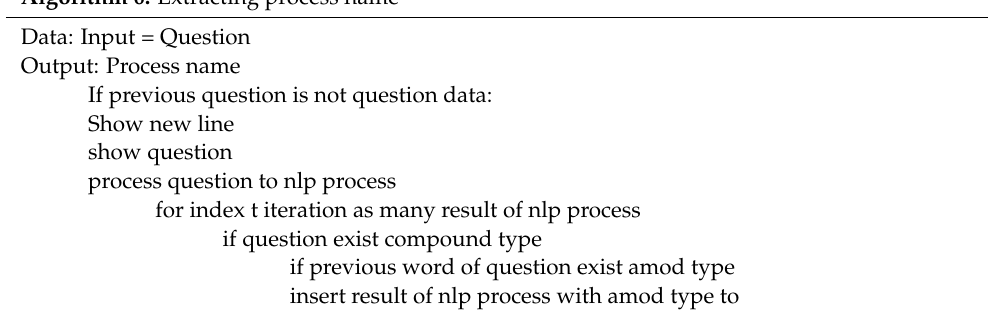
Algorithm 6. Extracting process